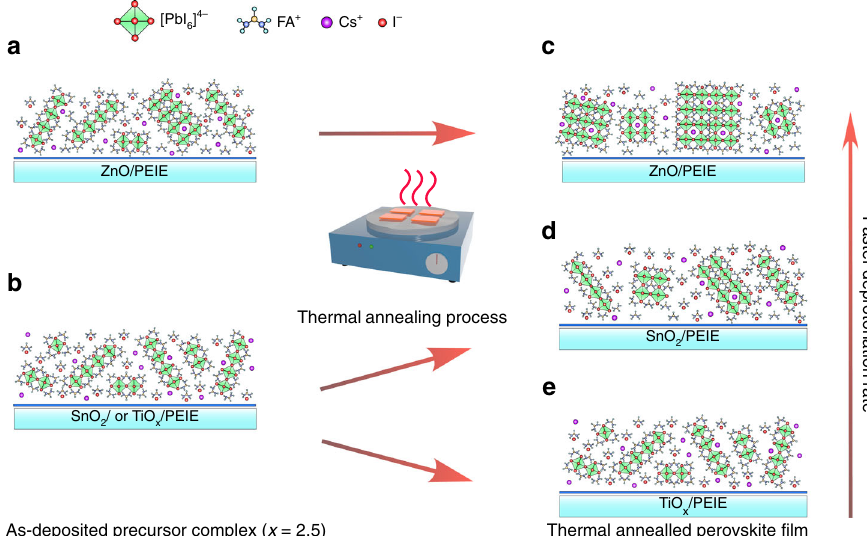
Fig. 4 Schematic illustration of perovskite ( x = 2.5) crystallization on different substrates. a , b The as deposited perovskite precursor complexes on ZnO/ PEIE ( a ) and on TiO x /PEIE or SnO 2 /PEIE ( b ) substrates. c – e The thermal annealed perovskite fi lms on ZnO/PEIE ( c ), SnO 2 /PEIE ( d ) and TiO x /PEIE ( e ) substrates,